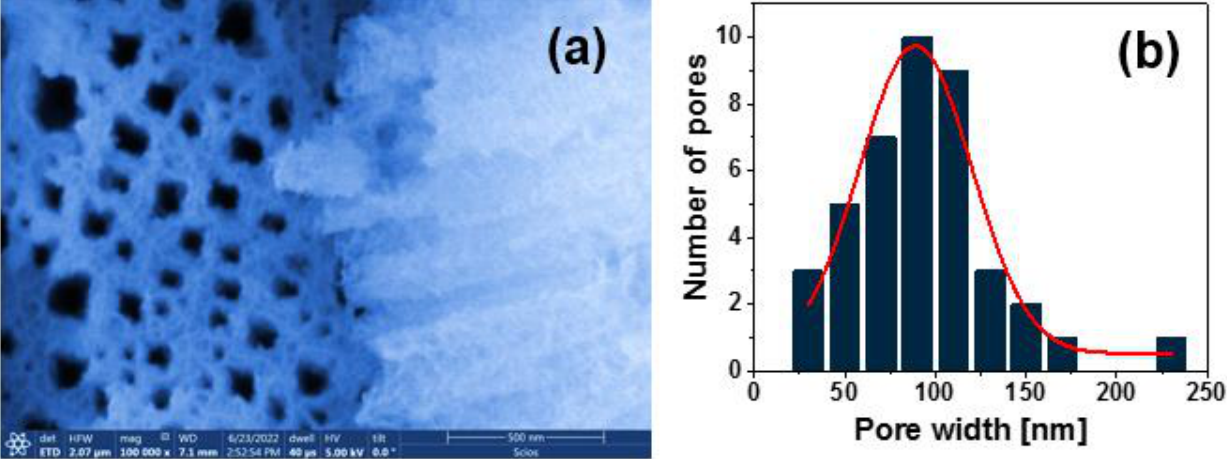
Figure 3. ( a ) SEM micrograph of the A4 PSi layer; ( b ) average size distribution of the pores obtained by particle counting.